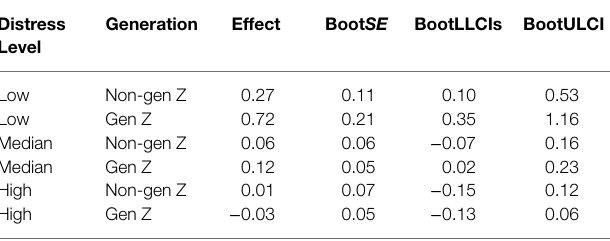
TABLE 3 | Conditional indirect effects of sport community involvement on life satisfaction via PsyCap. Distress Level